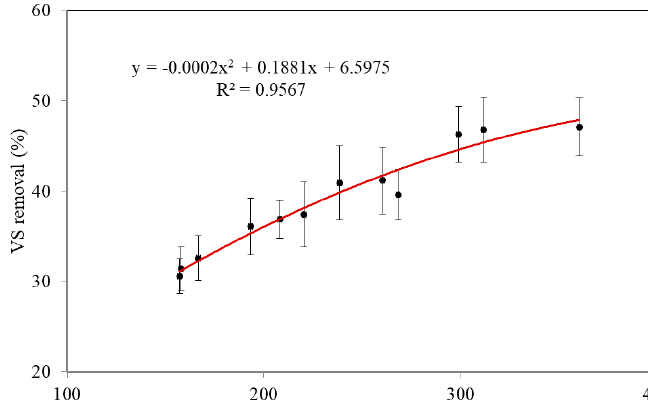
Figure 4. Correlation of biogas produced per g volatile solids (VS) and percentage of VS removal for all the experiments.